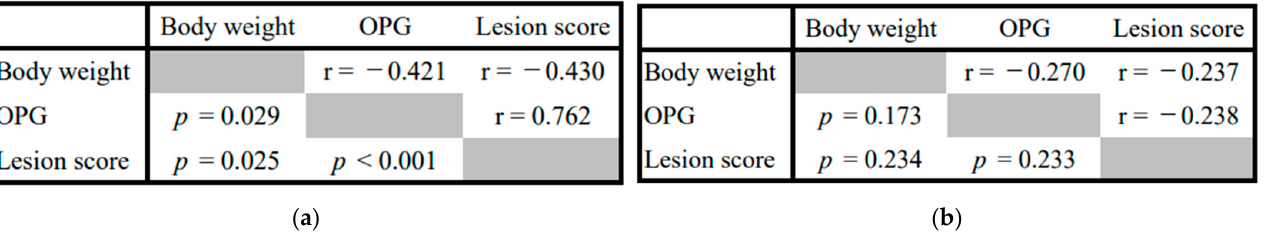
Figure 2. The Pearson product–moment correlation coefficient between the body weights, number of oocysts (OPG), and intestinal lesion scores of the coccidiosis-infected broilers. The p values are shown in the lower left and the rho values in the upper right. ( a ) Twenty-nine days of age; ( b ) Forty-nine days of age.